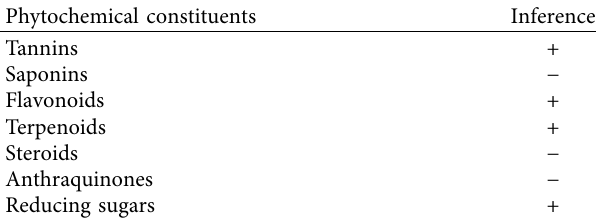
Table 3: Phytochemical constituents of G. biloba tea extract. Phytochemical constituents